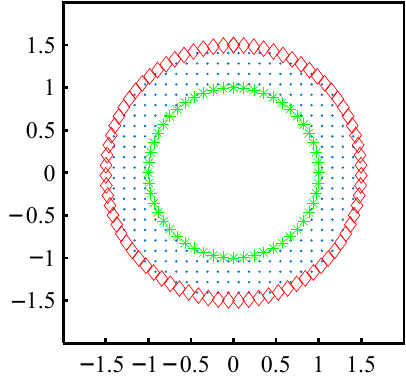
Figure 6. Collocation nodes’ distribution.